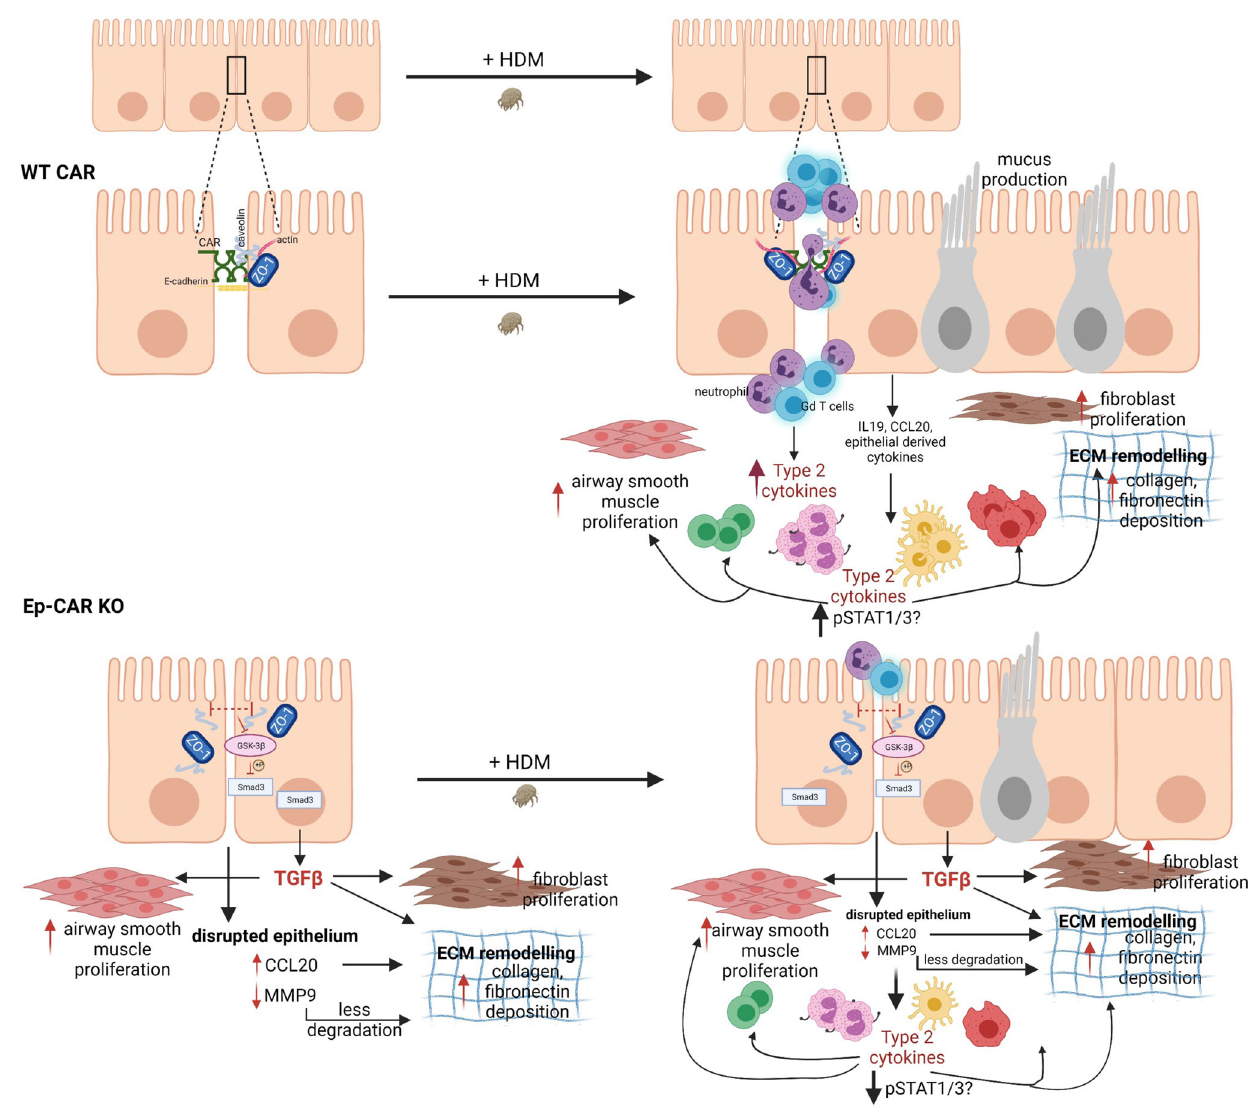
Fig. 9 | Model of CAR-dependent functions in airway homoeostasis and in fl ammation. TopschematicshowsproposedfunctionsforCARinmediatingpro- in fl ammatory factor release to enhance immune cell in fi ltration following HDM exposure. Bottom panels show destabilisation of epithelial cell – cell adhesions